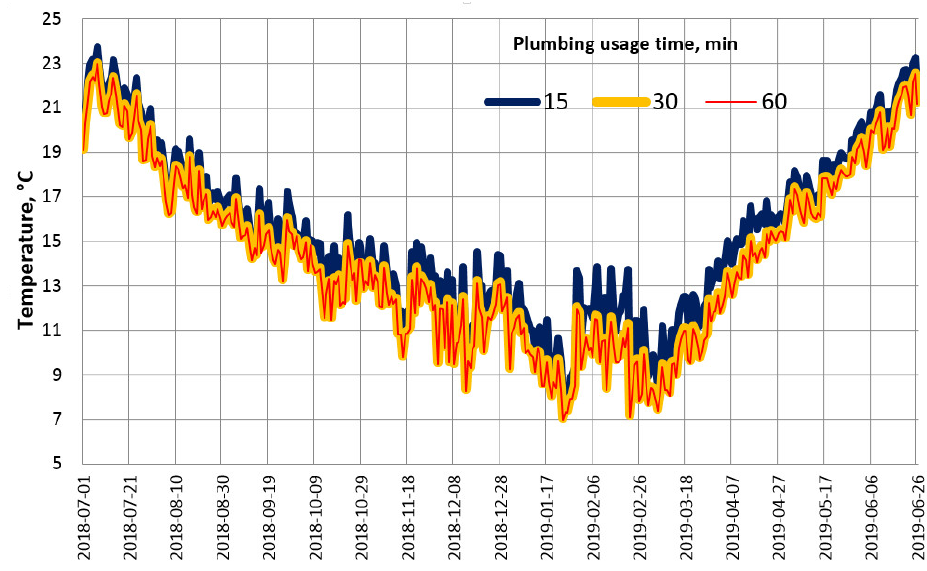
Figure 5. Average daily cold water temperature distribution for the draw-off point.